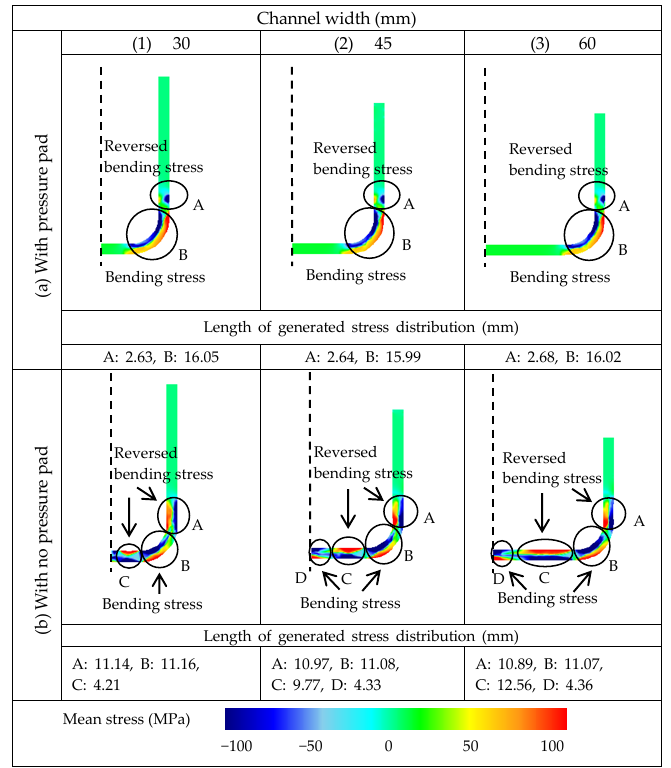
Figure 4. Comparison of the stress distribution analyzed in the workpiece, before unloading, with respect to various channel widths ( θ : 90 ◦ , R p : 7 mm, t : 3 mm, WP L : 120 mm, R ud : 5